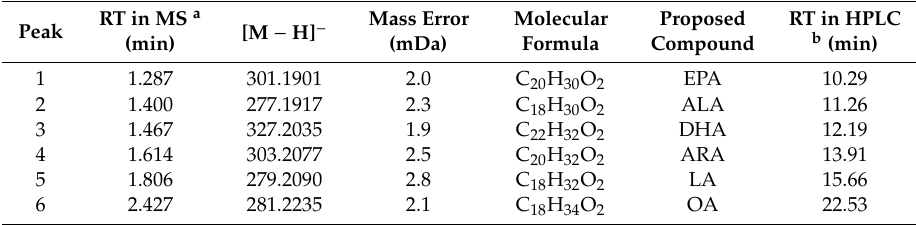
Table 3. The unsaturated fatty acid (UFA) compounds corresponding to the six principal peaks in the HPLC chromatogram of Rana chensinensis ovum oil